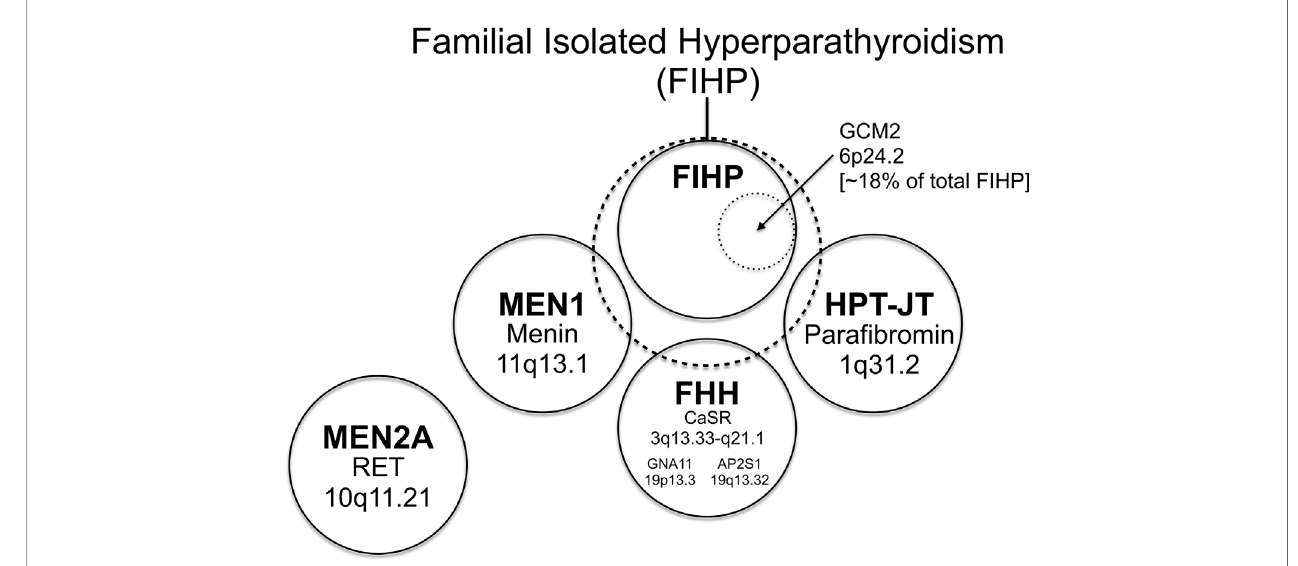
FIGURE 2 | The relationship among familial forms of hyperparathyroidism that may present as familial isolated hyperparathyroidism (FIHP) as a Venn diagram. The large dashed circle represents the set of patients that can present with a provisional diagnosis of FIHP at the time of initial ascertainment. This includes patients with FIHP who have been evaluated for, but lack fi ndings diagnostic of, MEN1, FHH, and HPT-JT (nonsyndromic FIHP; in a solid circle). Approximately 18% of nonsyndromic FIHP kindreds harbor germline gain-of-function mutations in GCM2 (inner dotted circle) (see text), whereas the remainder have currently unknown genetic etiologies. Subsets of patients with incomplete expression of MEN1, FHH and HPT-JT (the total set of patients in each syndrome represented by a solid circle) can also present with the FIHP phenotype (and thus overlap with the large dashed circle). The distinction between the nonsyndromic FIHP category and the syndromic categories arbitrarily depends on the depth and rigor of evaluation and the sensitivity of diagnostic tests used to detect the syndrome, testing that can include germline gene mutational analysis. MEN2A is a familial form of hyperparathyroidism that seldom if ever presents as FIHP, with patients usually coming to medical attention for signs and symptoms of medullary thyroid cancer and/or pheochromocytoma. Within each circle representing a de fi ned syndrome are included the genetic locus (or loci in the case of FHH; see text) of the syndromic trait and the associated gene product. The causative gene for HPT-JT that encodes para fi bromin is CDC73 , formerly called HRPT2 . The relationship among the patient sets illustrated as circles in this diagram is intended to be qualitative and neither the area of each circle nor the area of overlap between circles has any quantitative signi fi